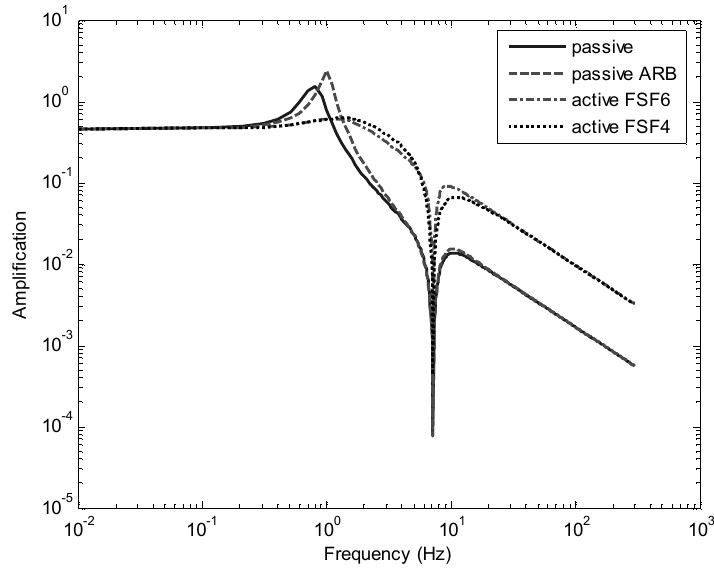
Fig. 14. Angular acceleration for lateral acceleration